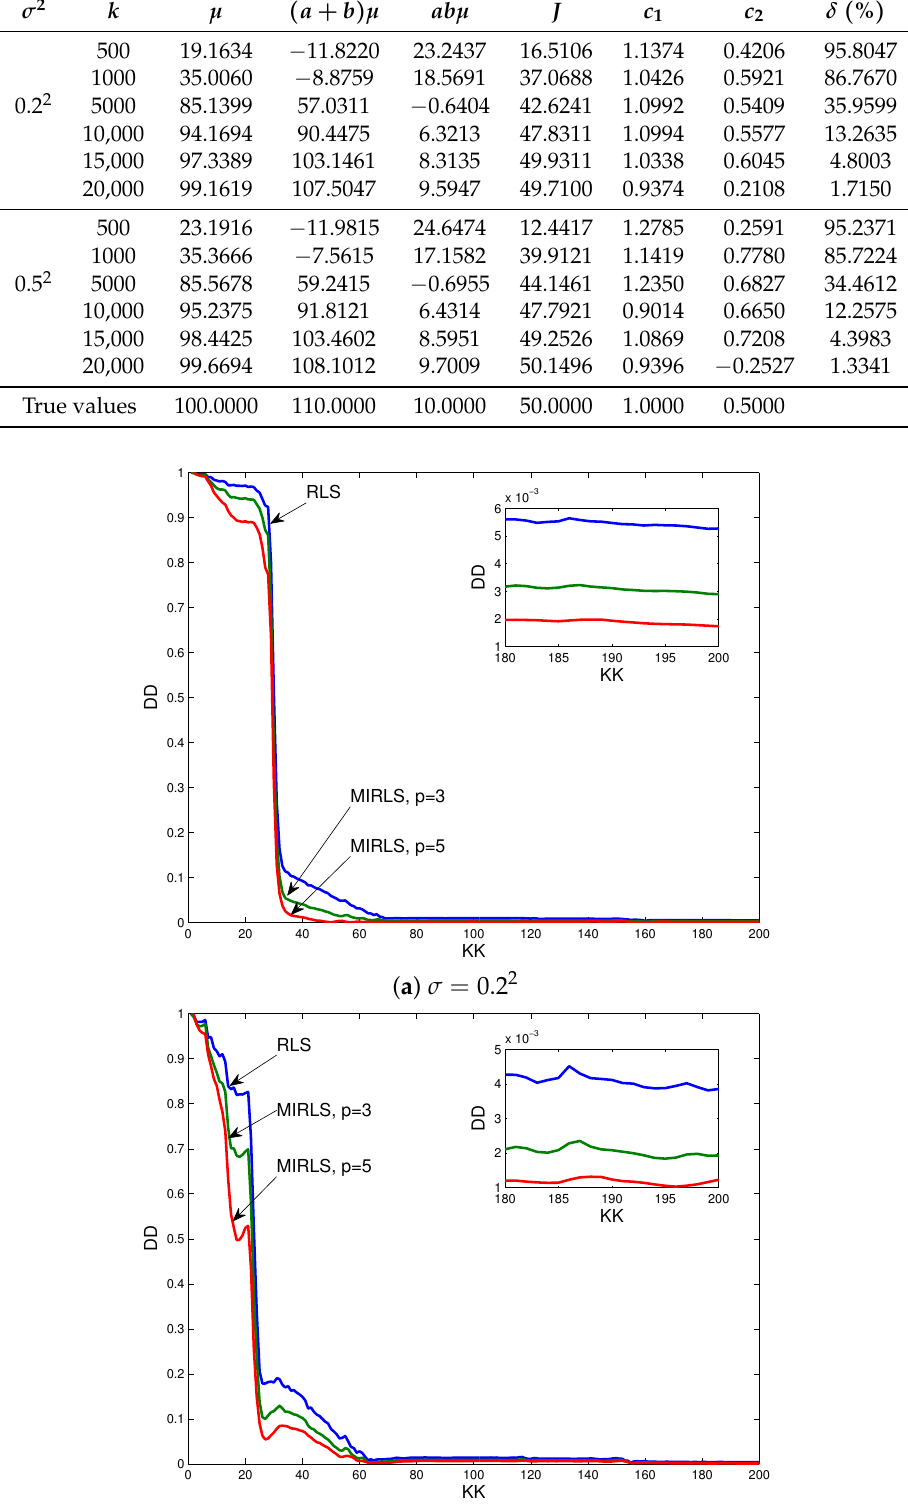
Table 4. The MISG estimates and errors ( p = 3).